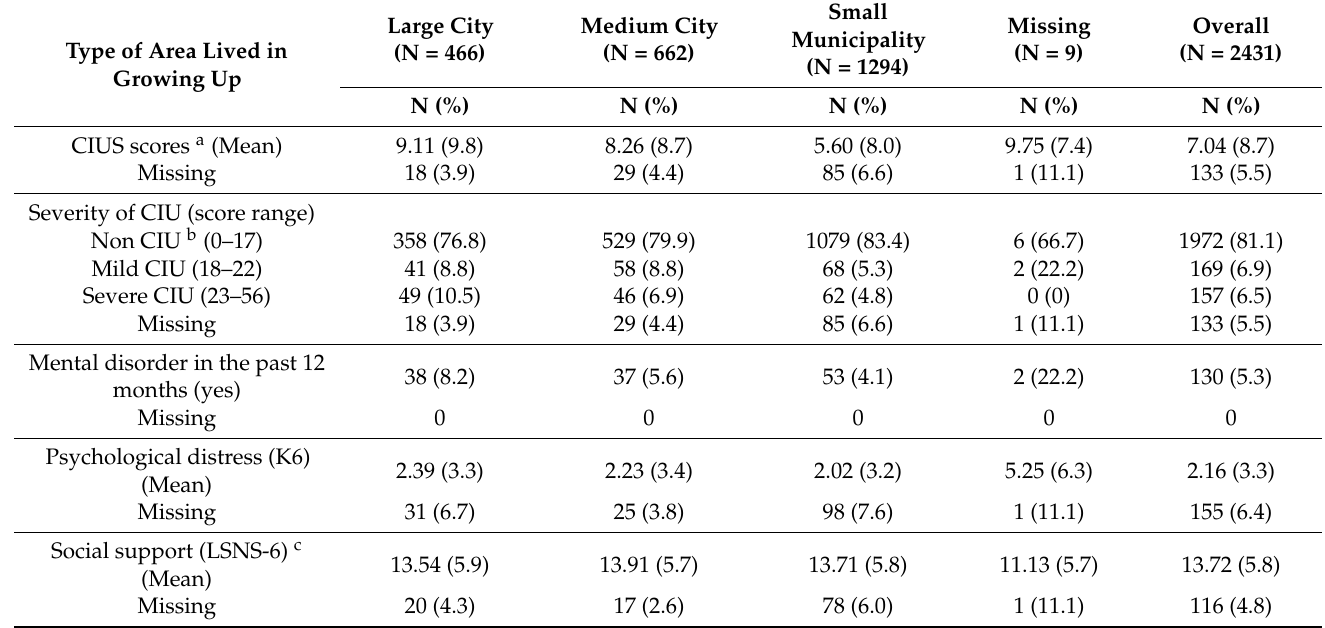
Table 1. Demographics and psychosocial characteristics of the participants (N =